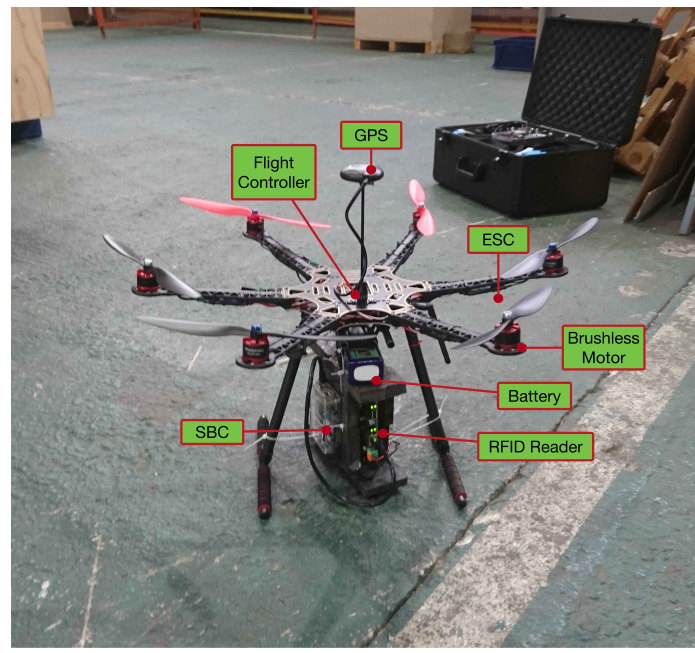
Figure 3. UAV used for the inventory and traceability